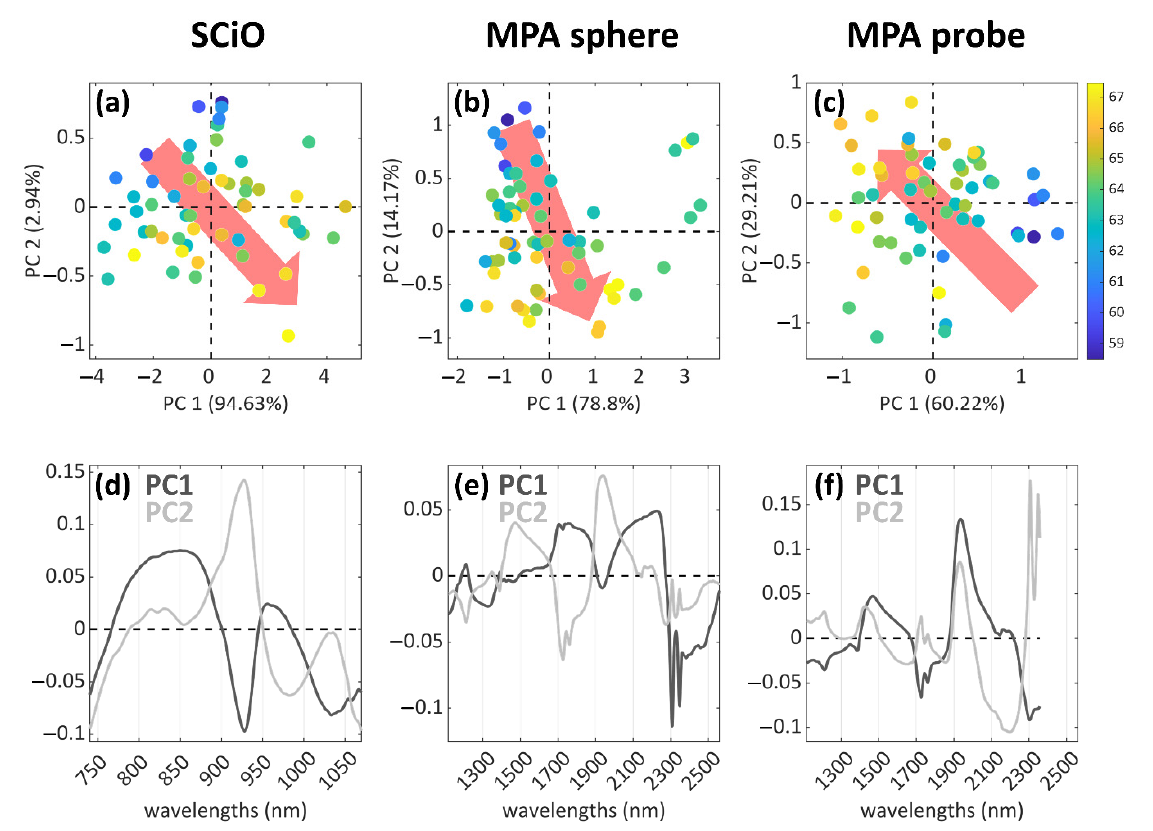
Figure 2. PCA results for the three analytical techniques of the study. The score plots are shown in the first row ( a – c ), with the samples coloured according to the lipid content and the content trends highlighted by the red arrows (from low to high). In the second row ( d – f ) the corresponding loadings plot are reported, showing the variables that are important for each PC reported in ( a – c ).